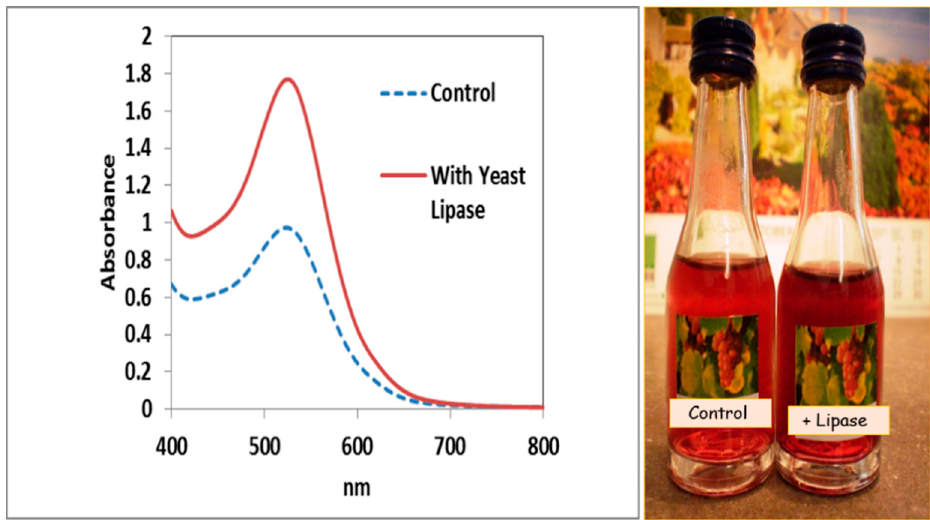
Figure 1. Color extraction from red grapes after a model fermentation without and in presence of a yeast lipase (Claus, unpublished data).